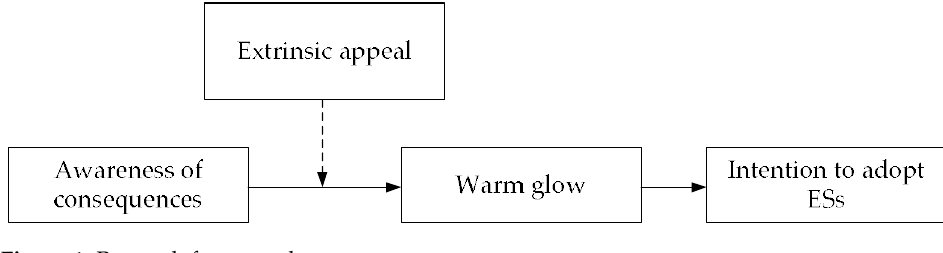
Figure 1. Research framework.